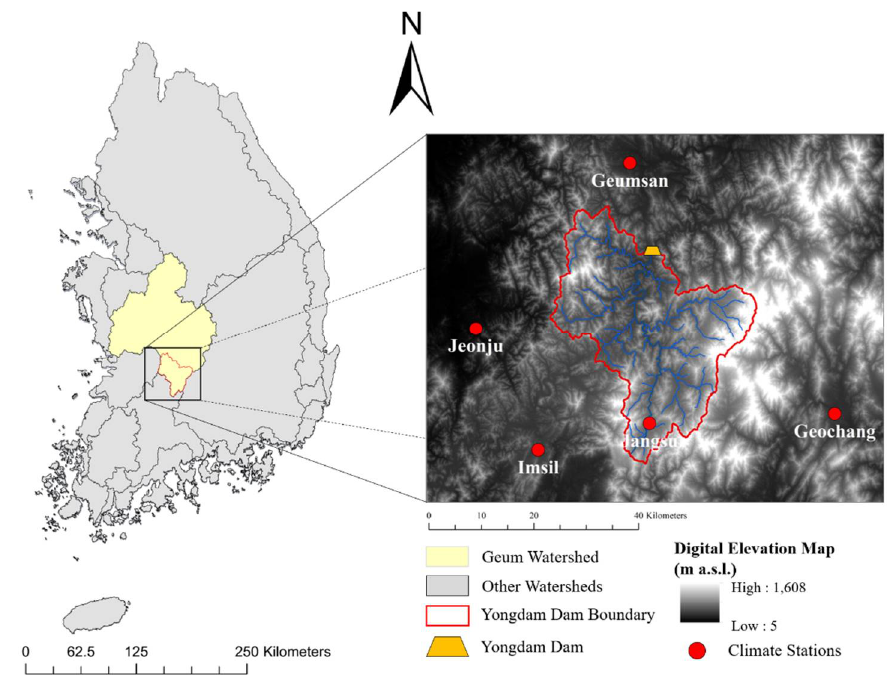
Figure 1. Location of the UGRB (red outline), Yongdam dam (orange trapezoid), and climate stations within Geum River basin (yellow) in South Korea.